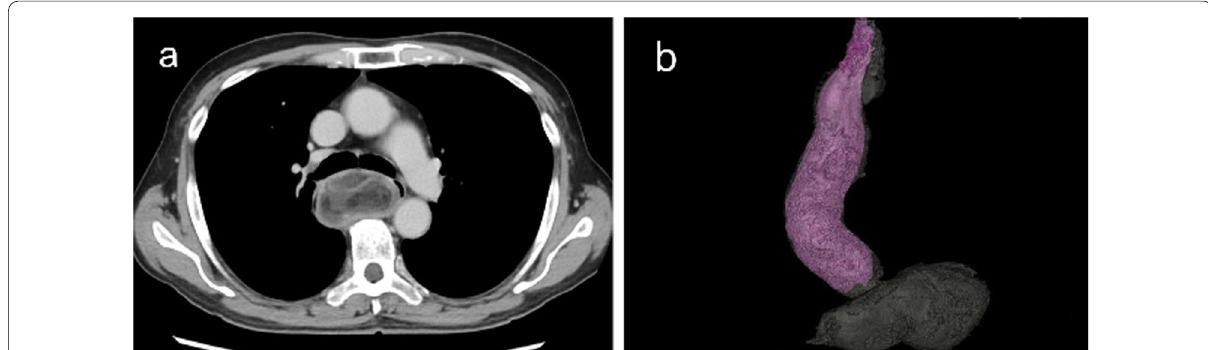
Fig. 2 a Preoperative contrast-enhanced CT showed a large pedunculated tumor hanging in the cervical esophagus. The inside of the tumor was heterogeneously contrasted, with a mixture of fatty, fibrous and vascular components. b 3D-CT showed that the tumor was an intraluminal polypoid tumor